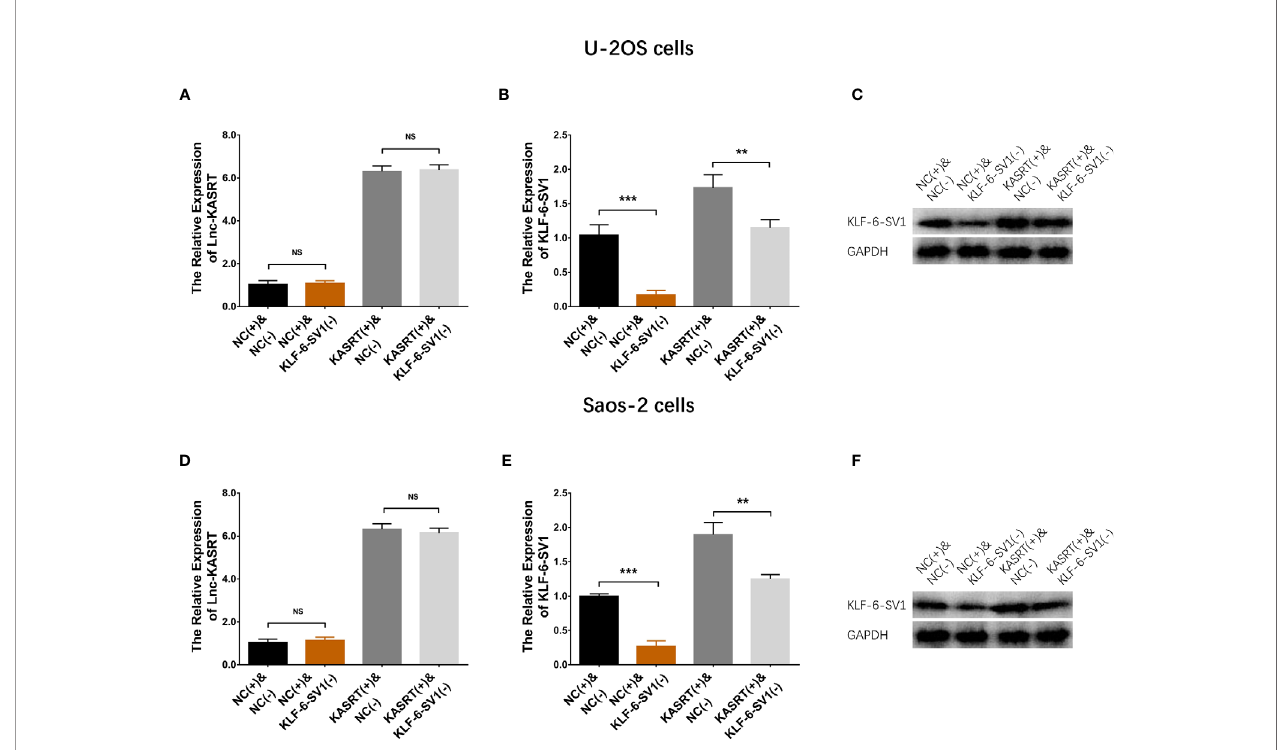
FIGURE 5 | Lnc-KASRT and KLF6-SV1 expression in compensatory experiments. Lnc-KASRT (A) , KLF6-SV1 mRNA (B) , and protein (C) expression among the groups of U-2OS cells. Lnc-KASRT (D) , KLF6-SV1 mRNA (E) , and protein (F) expression among the groups of Saos-2 cells. **P < 0.01, **P < 0.001, NS, Not signi fi cance (P >